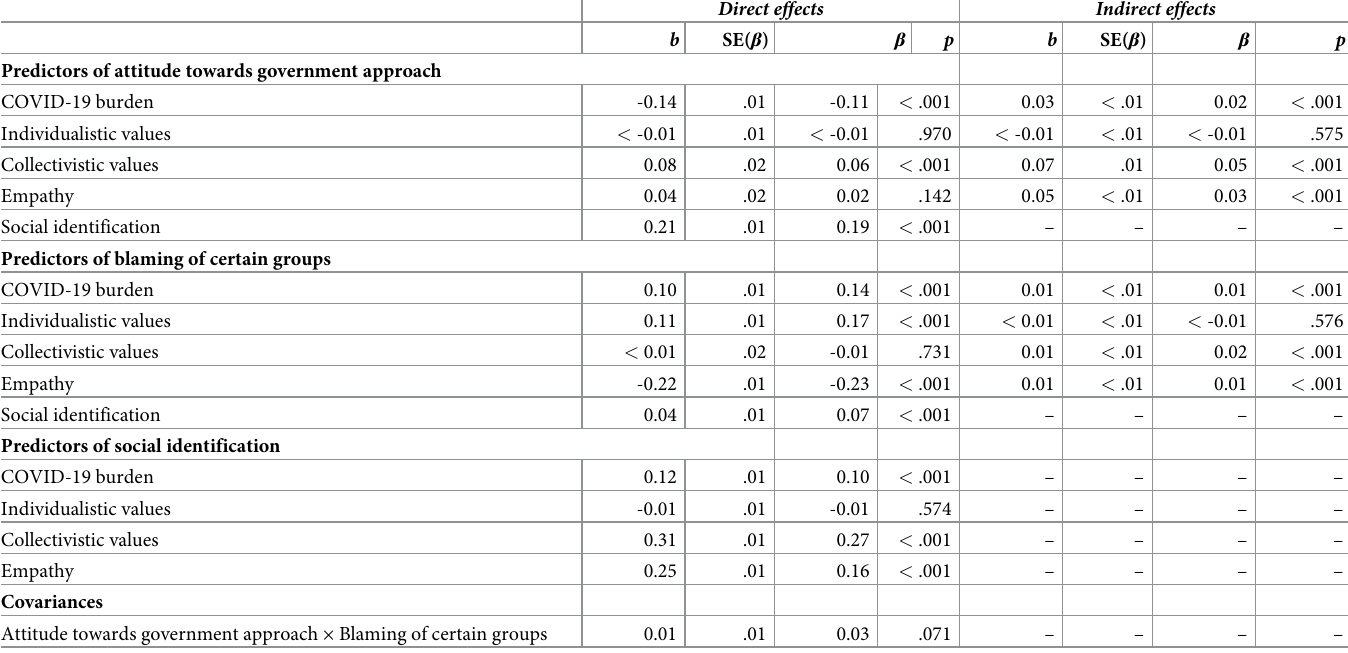
Table 3. Mediation model with attitude towards government approach and blaming of certain groups regressed on COVID-19 burden, individualistic values, col- lectivistic values, and empathy, mediated by social